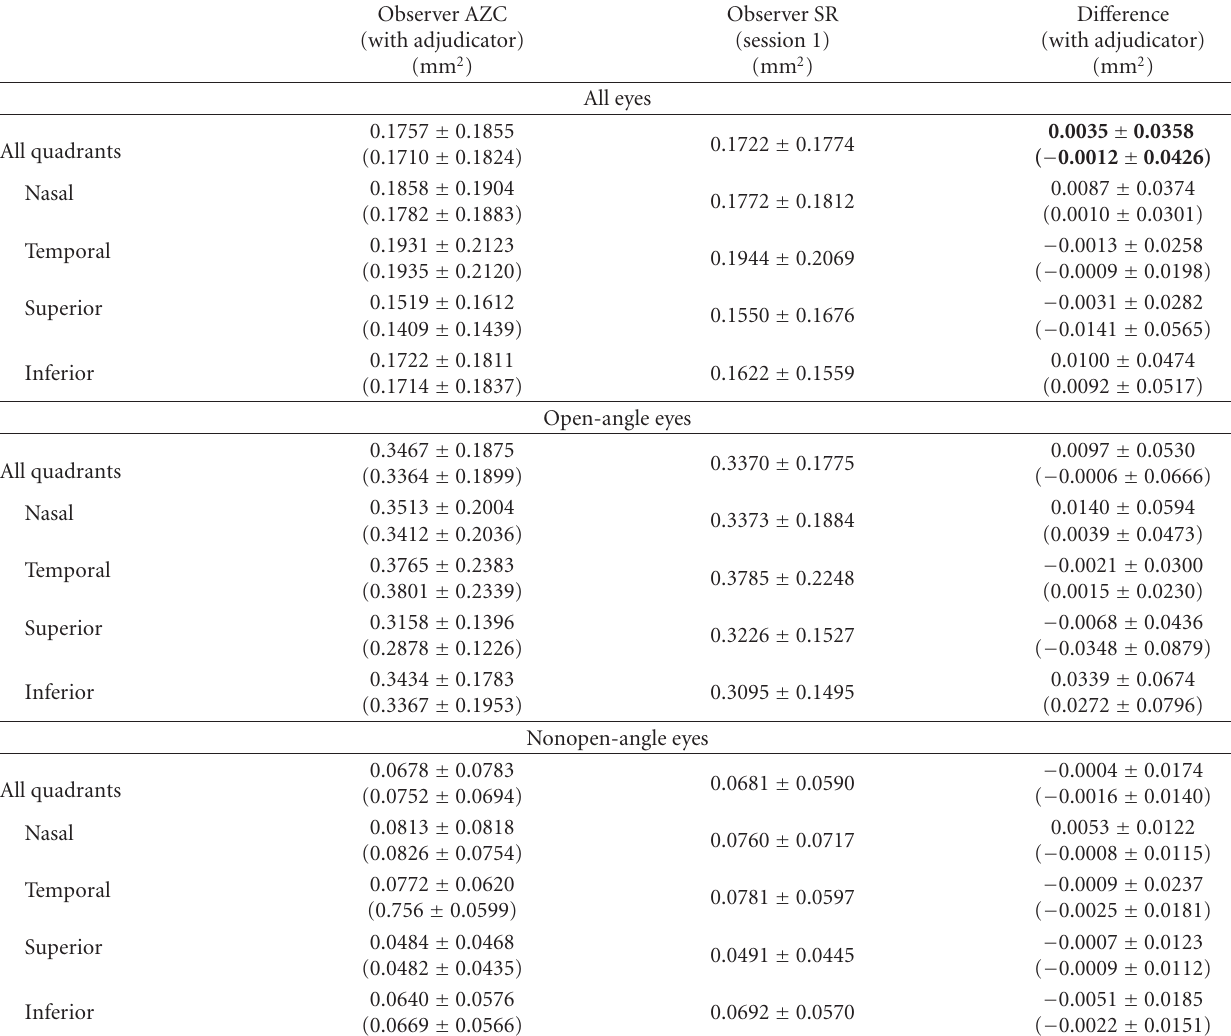
Table 5: Mean ( ± standard deviation) TISA750 (mm 2 ) from each observer and di ff